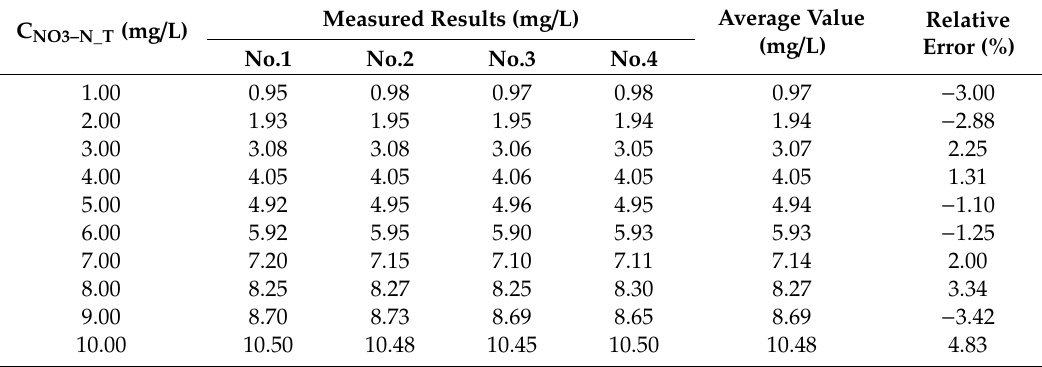
Table 8. Measured results and relative errors for di ff erent concentrations of NO 3 –N